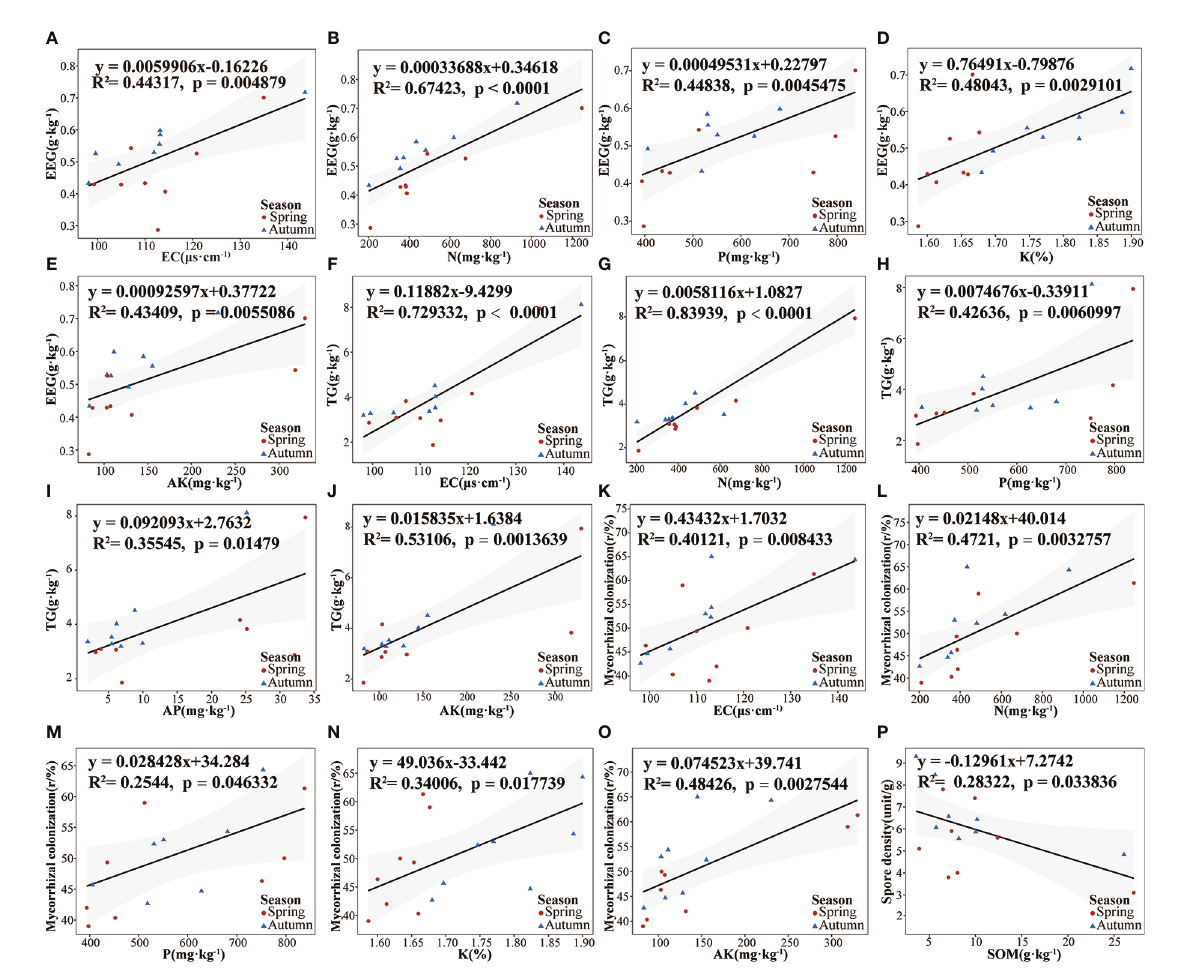
FIGURE 4 Linear regression relationships between soil physical and chemical properties and AMF-related environmental factors. (A – E) . EEG; (F – J) . TG; (K – O) . Mycorrhizal colonization; (P) . Soil spore density. CR, mycorrhizal colonization rate, SD, spore density; All linear regressions were fi tted using the OLS model; gray shading represents 95% con fi dence